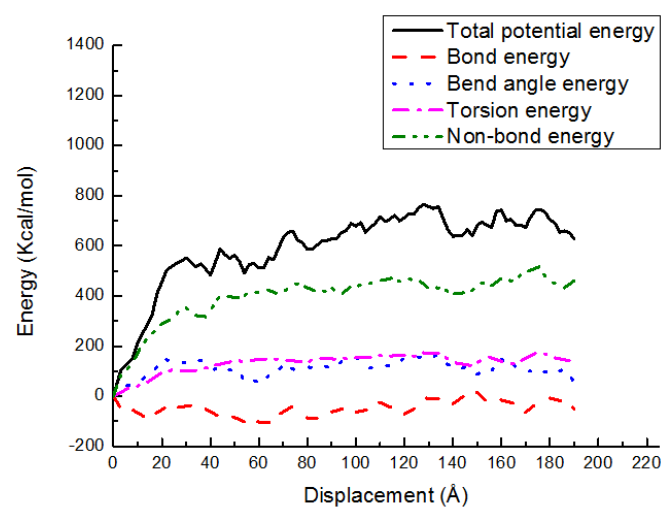
Figure 15. Potential energy-displacement curves for the PE(150 – 40)/mS2 interface in the shear case.